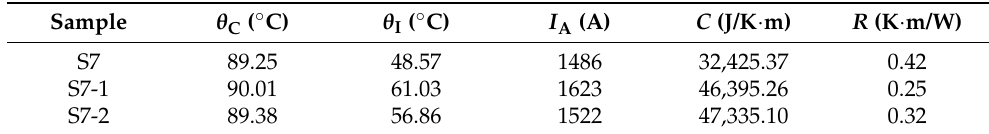
Table 3. Thermal parameters of the